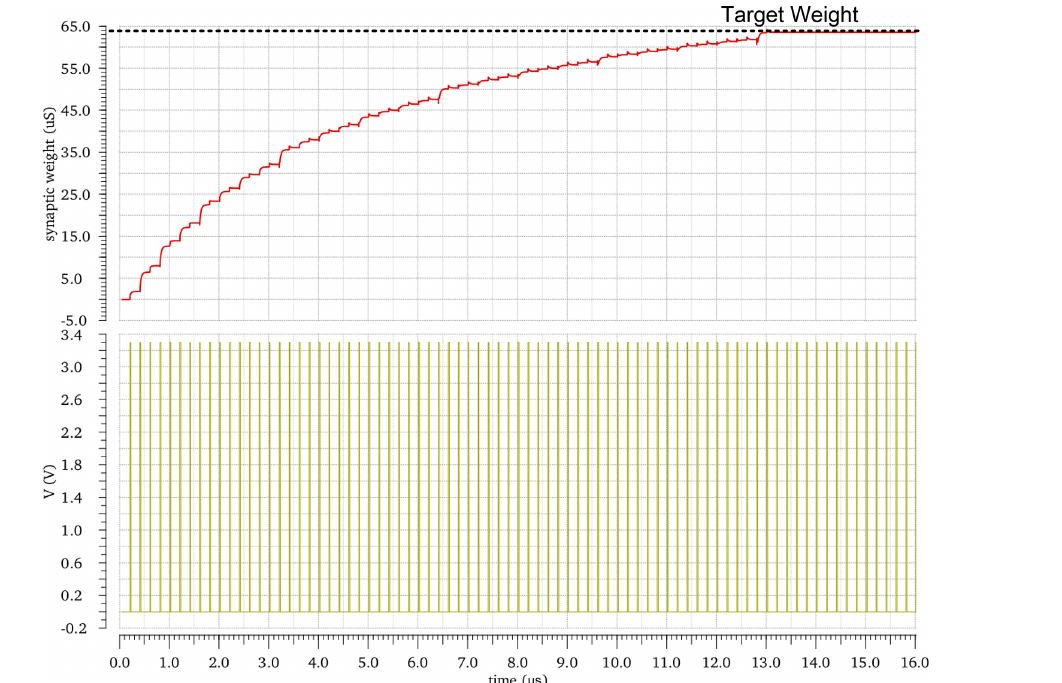
Figure 31. Target weight at V RFR equal to 800mV, vg1 and vg2 equal to 1V, and V LEAK equal to 700mV. Circuit conditions are V dd of 3 . 3V, and temperature equals 27 ◦ C and on the nominal process.